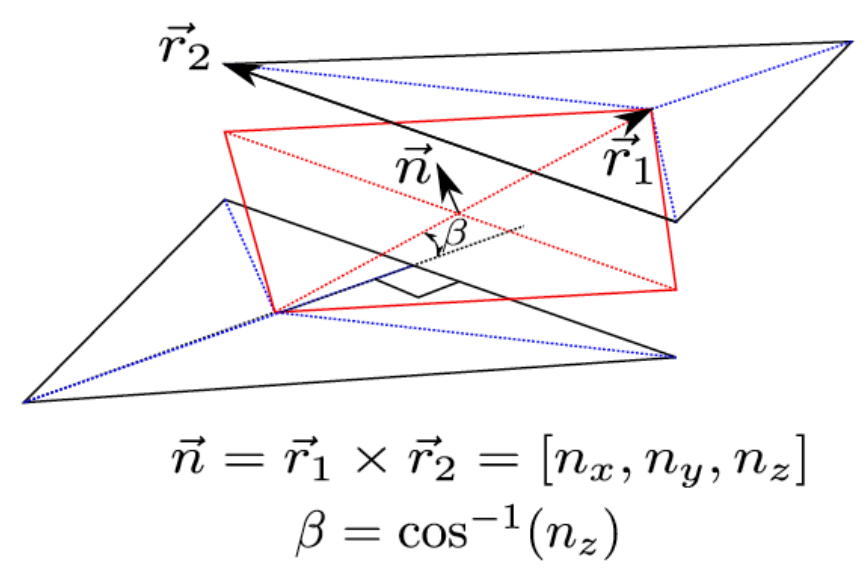
Figure 7. The geometric scheme followed in order to find the bed inclination.